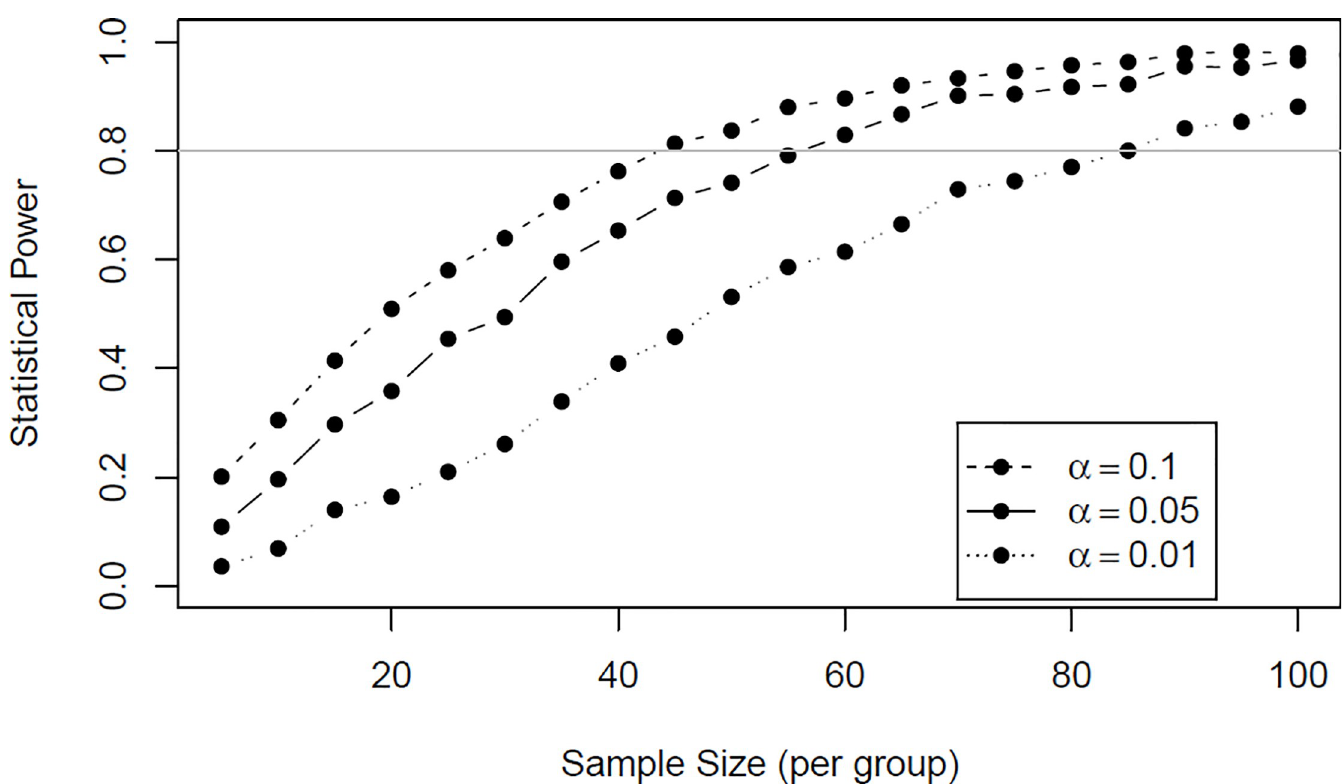
Fig 4. Post-hoc power analysis shows that approximately 55 participants per group with full observations would be required to demonstrate a difference at significance level of α = 0.05 with 0.80 power for day 14